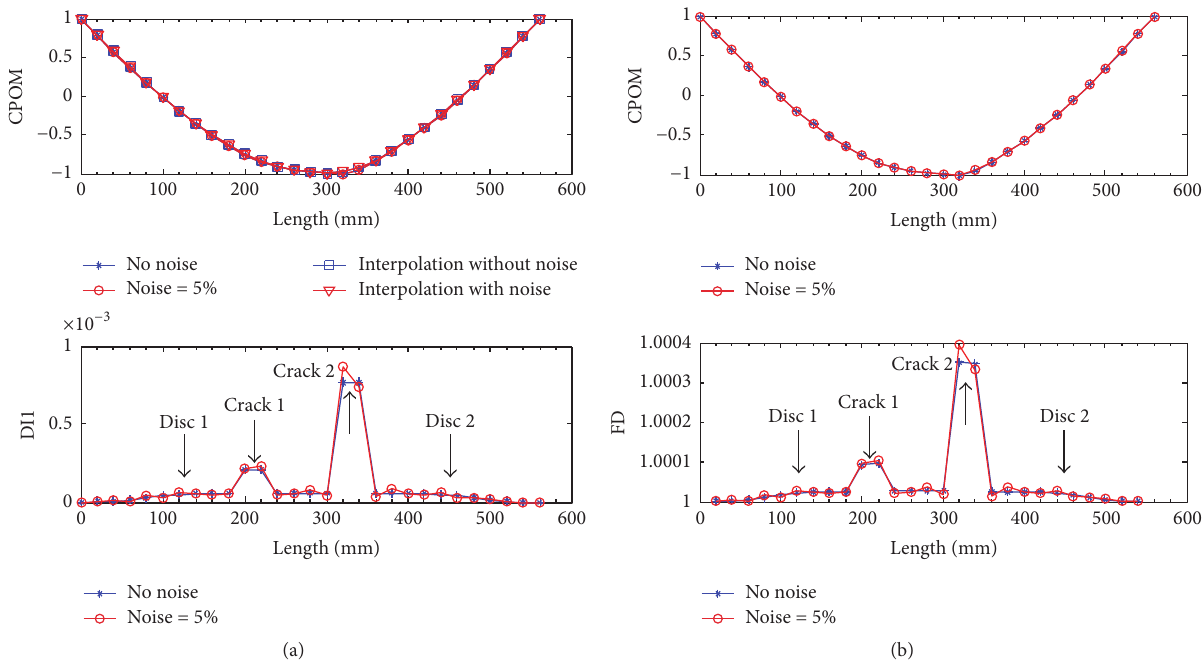
Figure 14: Localization results of double-cracked rotor in case 7. (a) Localization using GSM by linear gapped interpolation. (b) Localization using